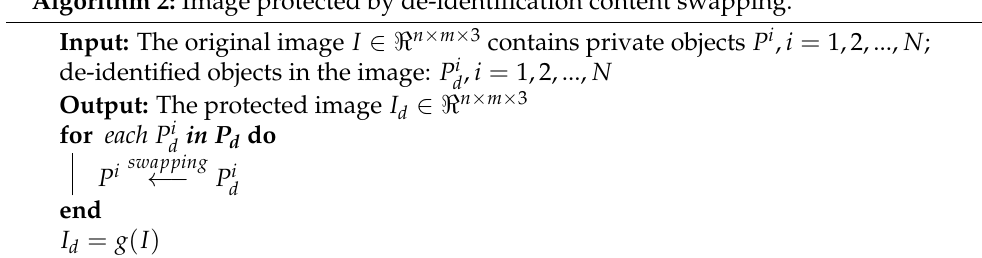
Algorithm 2: Image protected by de-identification content swapping.